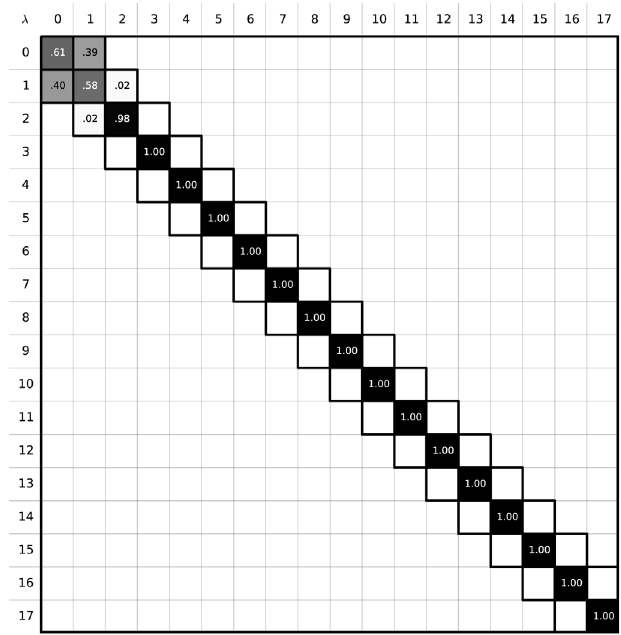
Figure 5. Phase space overlap between the states in the path between IEM and the fcc argon solid. A good free energy estimate is obtained when the states along the alchemical path contain configurations that can be found in other intermediate states. Here, however, the phase space overlap diagram shows that there is no overlap between the states λ energy